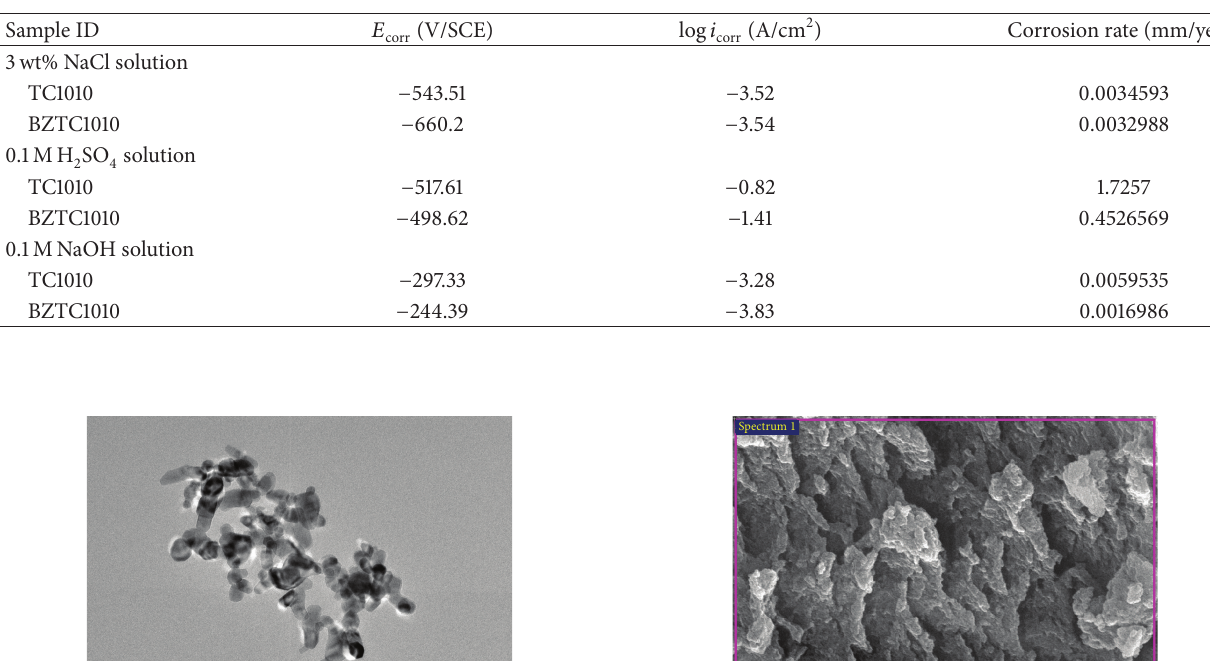
SO , and NaOH solutions. 2 4